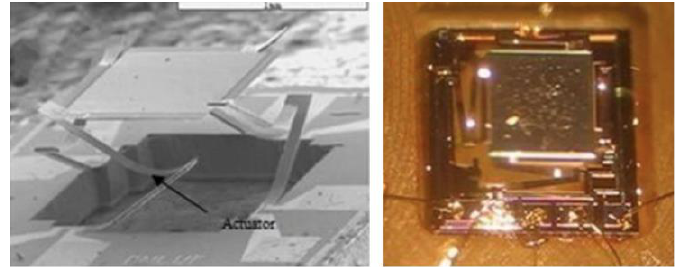
Figure 21. Pictures of MEMS moving mirrors. Reproduced with permission from [167].